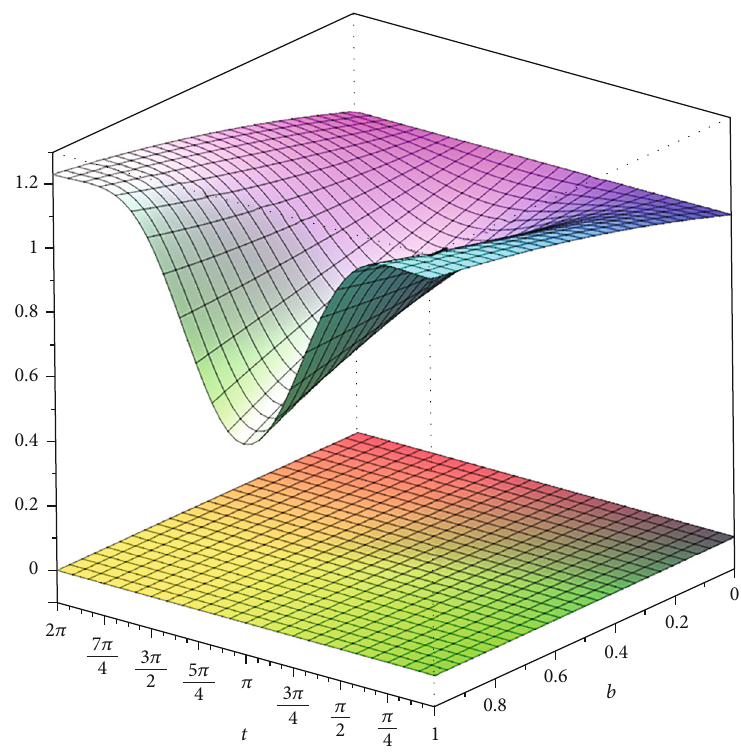
Figure 1: The plot of Ψ ð Re it Þ for t ∈ ½ 0, 2 π Þ , R = 1 , and α ∈ ð 10 − 6 , 1 (cid:2)